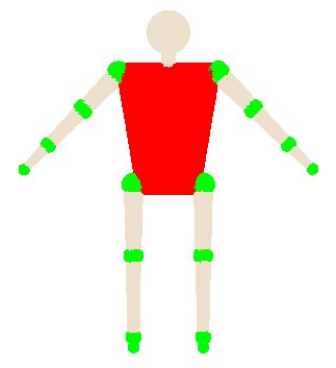
Figure 3. Geometric model using polispheres.